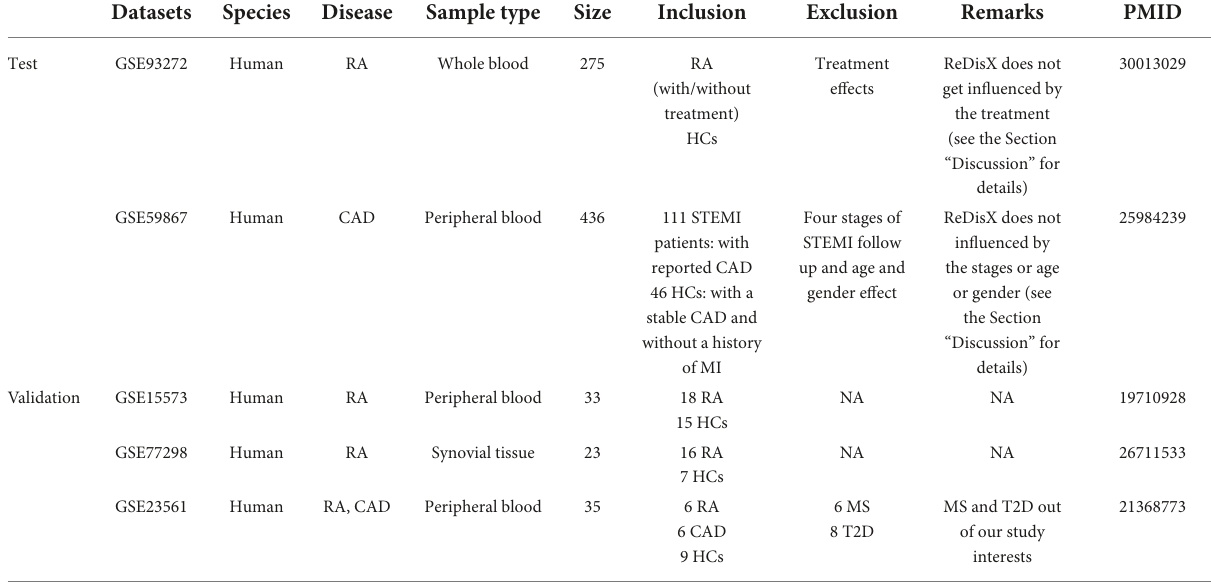
TABLE 1 Representation of the datasets used in our